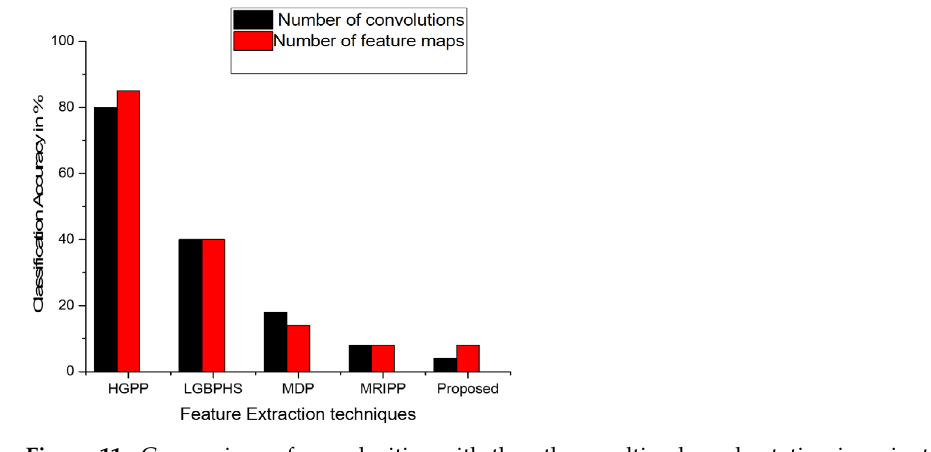
Figure 13. Comparison of accuracies by different classifiers for different datasets. The proposed BAO with PM operator is compared with other optimization algo- rithms while applying on JAFFE is shown in Figures 14 and 15. The Bat Algorithm (BA) and the proposed BAO-PM are compared with Whale Optimization Algorithm (WOA), Gray Wolf Optimization (GWO), Particle Swarm Optimization (PSO), Genetic Algorithm (GA), Gravitational Search Algorithm (GSA), and Ant Bee Colony (ABC) algorithm [49]. The BAO-PM utilizes a lower amount of time when compared to the other algorithms as it uses random fly technique and Pearson mutation that results in faster convergence. The best individuals are periodically sent from each subprocess to the main process using a centralized migration strategy. The main process then chooses the best individual from the entire population to broadcast to the subprocess, forcing the subpopulation to carry out the best evolution. The optimized parameters thus obtained using BAO-PM result in higher accuracy.